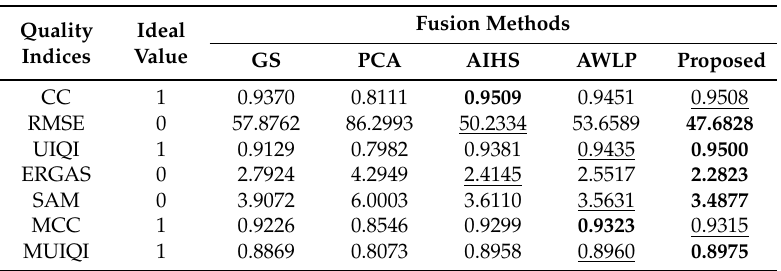
Table 2. Quantitative evaluation results of the IKONOS experiment (the best result is marked in bold, and the second best result is underlined).